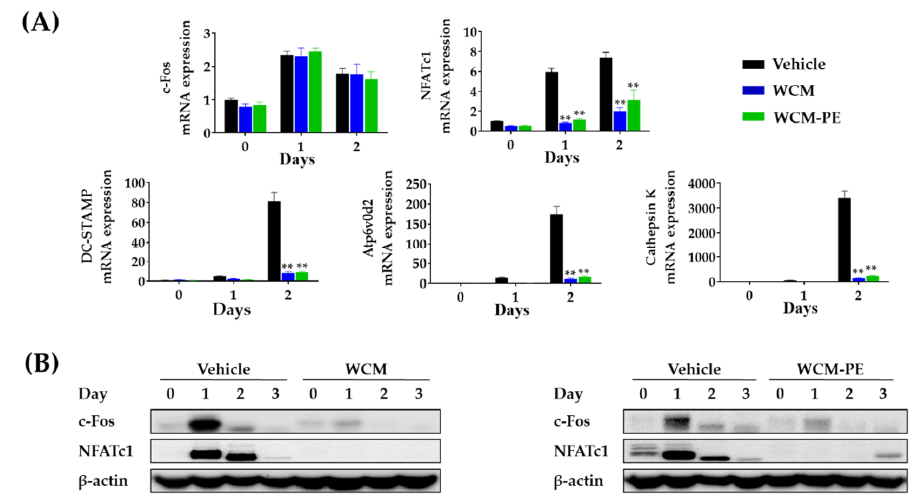
Figure 4. Molecular mechanism underlying the water extract of Commiphora myrrha resin (WCM)-and its polysaccharides (WCM-PE)-related modulation in osteoclastogenesis of bone marrow-derived macrophages (BMDMs). ( A ) Inhibitory ef- fects of WCM and WCM-PE on mRNA expression of key transcription factors and osteoclast-specific genes implicated in cell fusion and maturation. ( B ) Inhibitory effects of WCM and WCM-PE on protein expression of c-Fos and NFATc1. β- actin was used as control. Quantitative real-time PCR data are presented as mean ± SEM and analyzed by two-way ANOVA with Bonferroni test., ** p < 0.01 versus vehicle control.